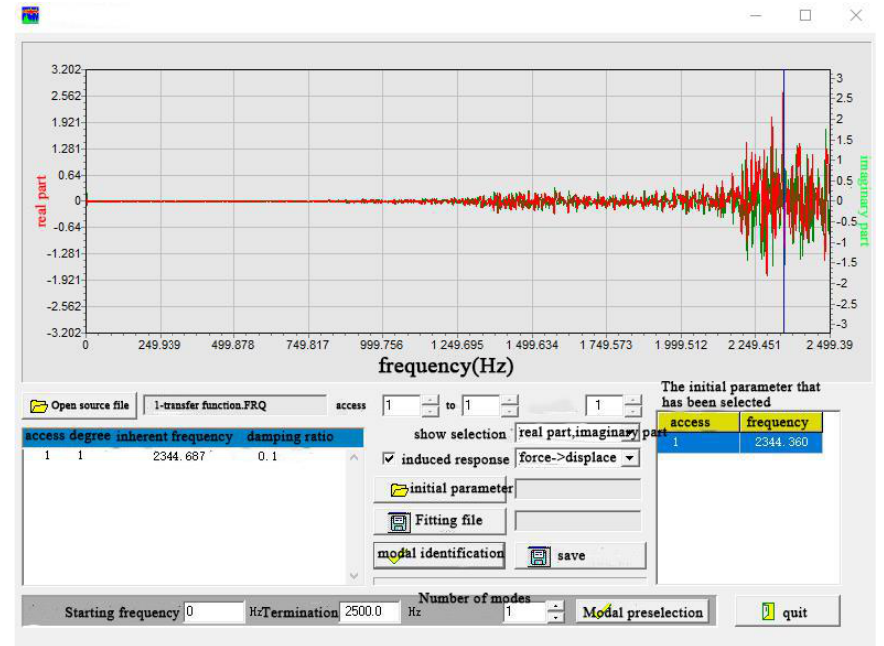
Figure 2. Results of modal analysis of first set of soil hammering tests.